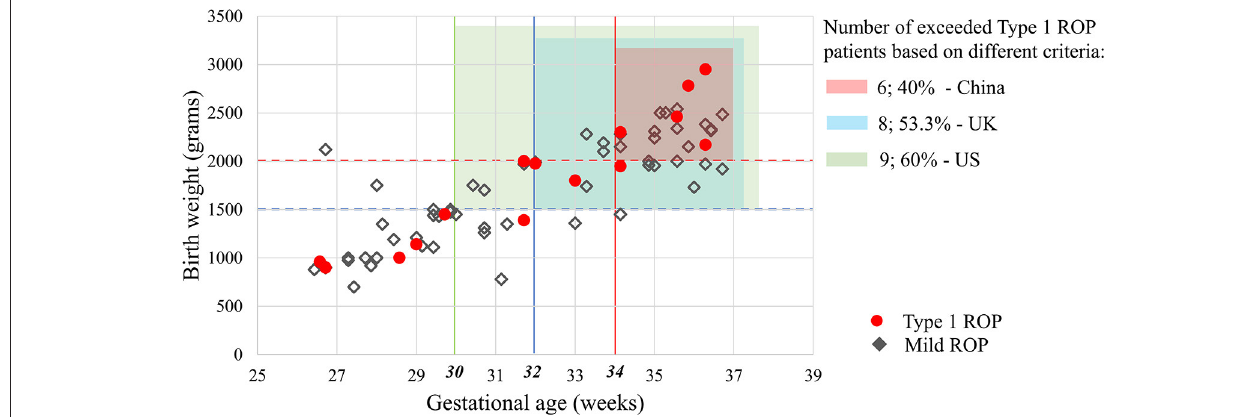
FIGURE 1 | Applicability of the screening guidelines of the US, UK and China in the present study. Based on different screening criteria in these countries, 25.4–52.1% of infants with ROP and 40–60% of Type 1 ROP patients in this study would have been missed. Mild ROP was defined as Type 2 ROP or a less severe ROP that did not require treatment in this study.